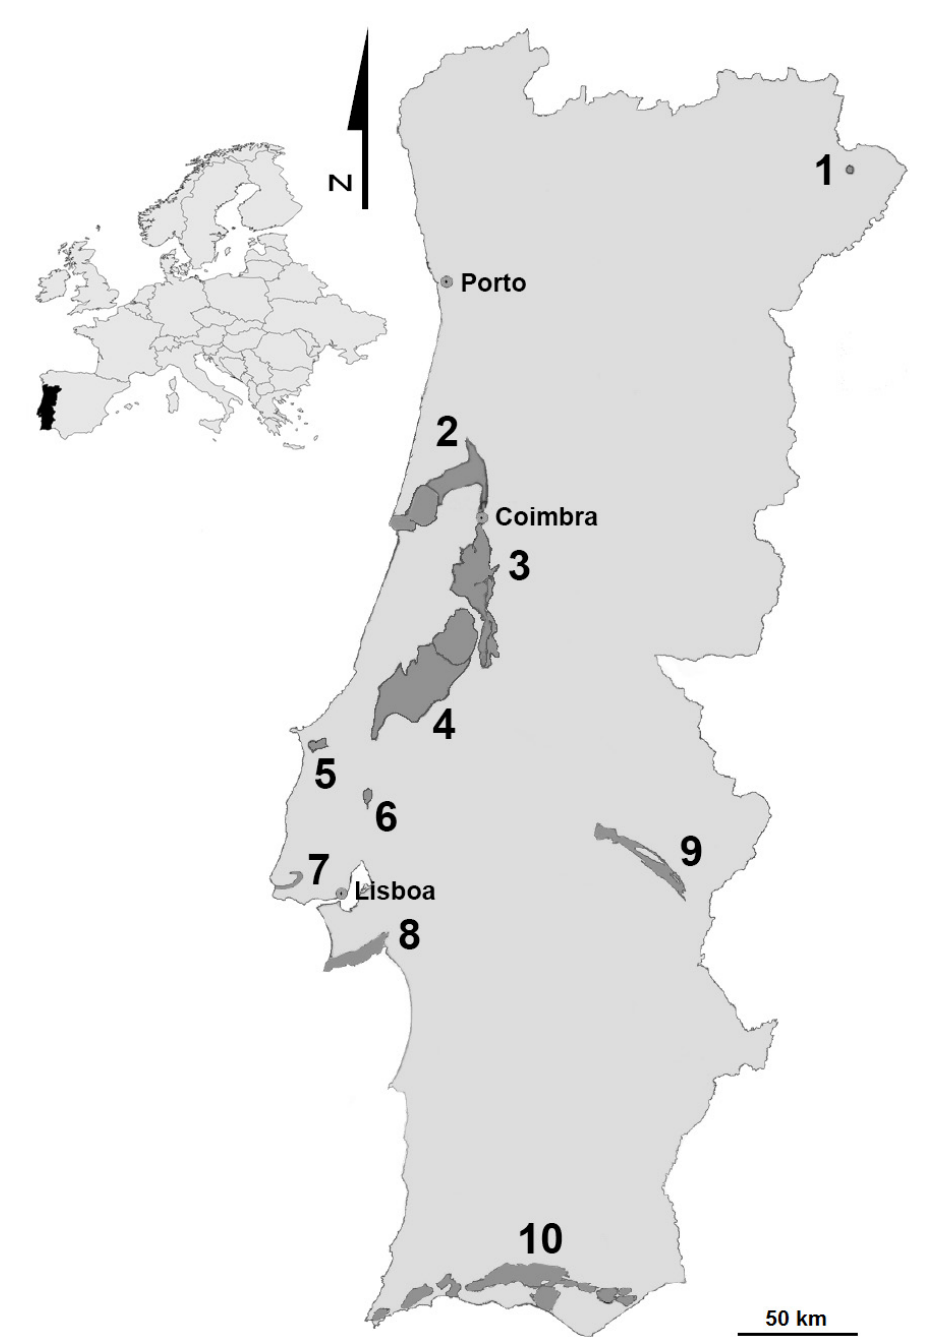
Fig. 1. Location of the main karst areas of Portugal. 1. Vimioso. 2. Cantenhede-Outil. 3. Sicó. 4. Estremenho. 5. Cesaredas. 6. Montejunto. 7. Lisbon Peninsula. 8. Arrábida. 9. Estremoz-Cano. 10.